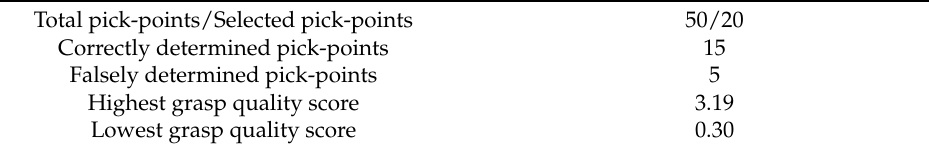
Table 4. Simulation results. Source: own.